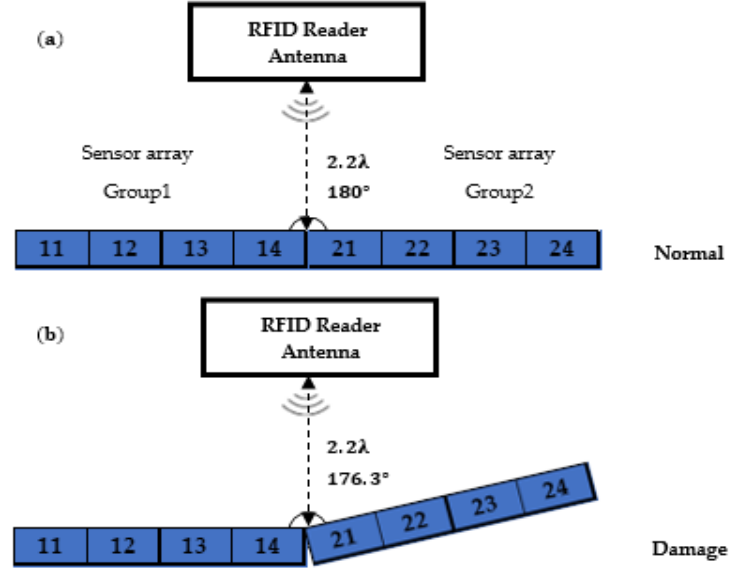
Figure 13. Twist line array test setup, ( a ) normal conditions, ( b ) damaged.